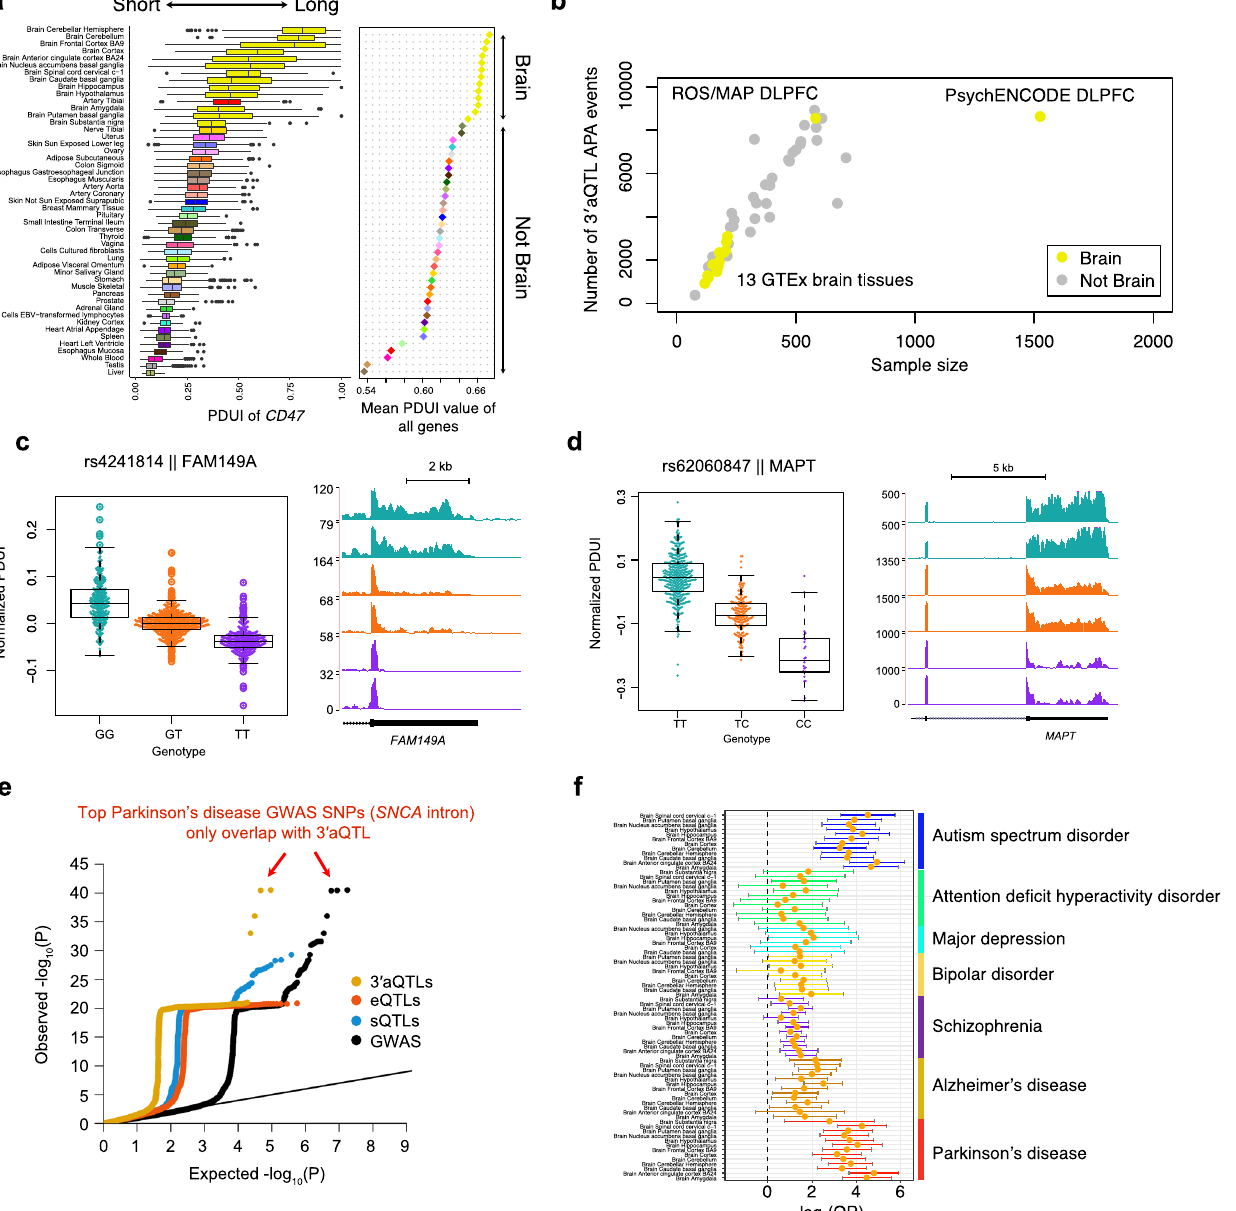
Fig. 2 | 3 ′ aQTLs explain a large portion of brain disorder heritability. a PDUI values of49GTEx tissues show thattranscripts expressed in the brain tissues have longer3 ′ UTRsthannon-braintissues.TheleftpanelisthePDUIofanexamplegene CD47 ( n =15,201RNA-seqsamples).TherightpanelshowsthemeanPDUIvaluesfor all genes. A higher PDUI value corresponds with longer 3 ′ UTR usage. The color of eachtissue correspondswiththoseusedinthe GTExcohort.The center horizontal lineswithintheplotrepresentthemedianvaluesandtheboxesareboundedbythe 25th and 75th percentile. The whiskers extend to the maximum and minimum values within 1.5 times of the interquartile range. b The number of 3 ′ aQTL APA events highly correlates with the sample size in each tissue. Each dot indicates a tissue type. Yellow and gray dots indicate brain and non-brain tissue types, respectively. c Example of a SNP (rs4241814) that is strongly associated with FAM149A 3 ′ UTRusagein the brain. Leftpanel:Distribution of the normalized PDUI valuesfor each genotype. Eachdot in the boxplot representsthe normalized PDUI value for one particular sample in the ROS/MAP cohort ( n =579 biologically inde- pendentsamples).Thecenterhorizontallineswithintheplotrepresentthemedian